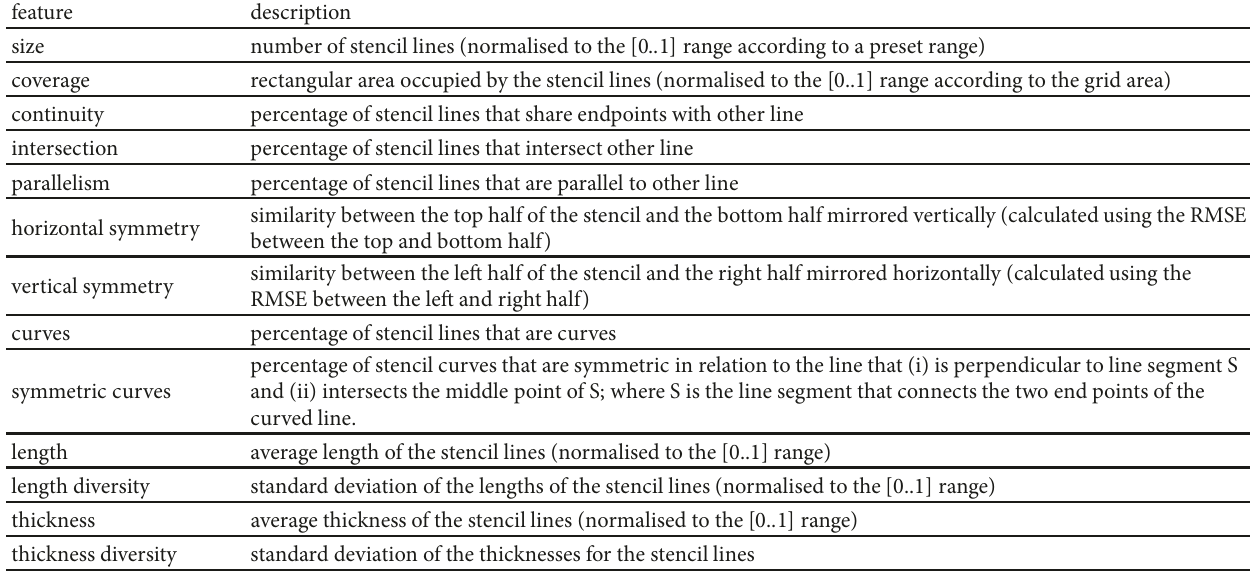
Table 2: Morphology features.